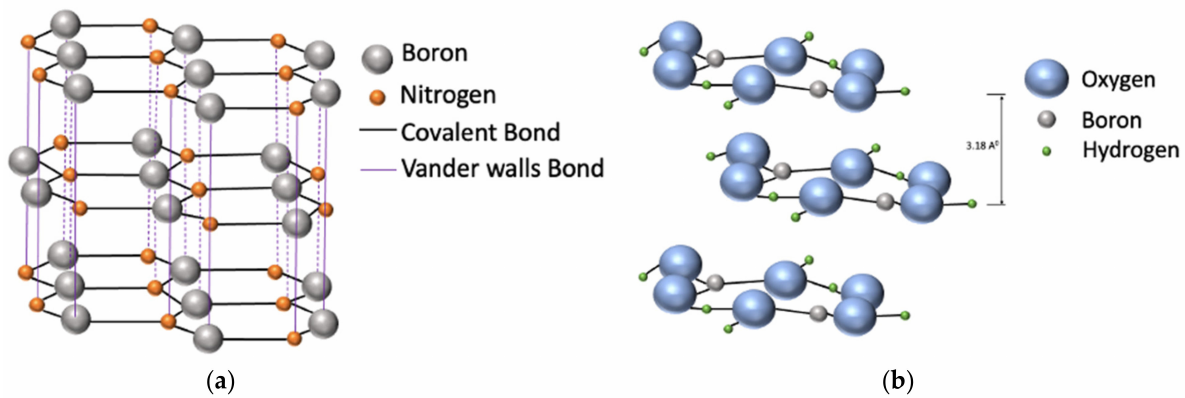
Figure 16. Structure of h-BN and boric acid: ( a ) hexagonal boron nitride and ( b ) boric acid